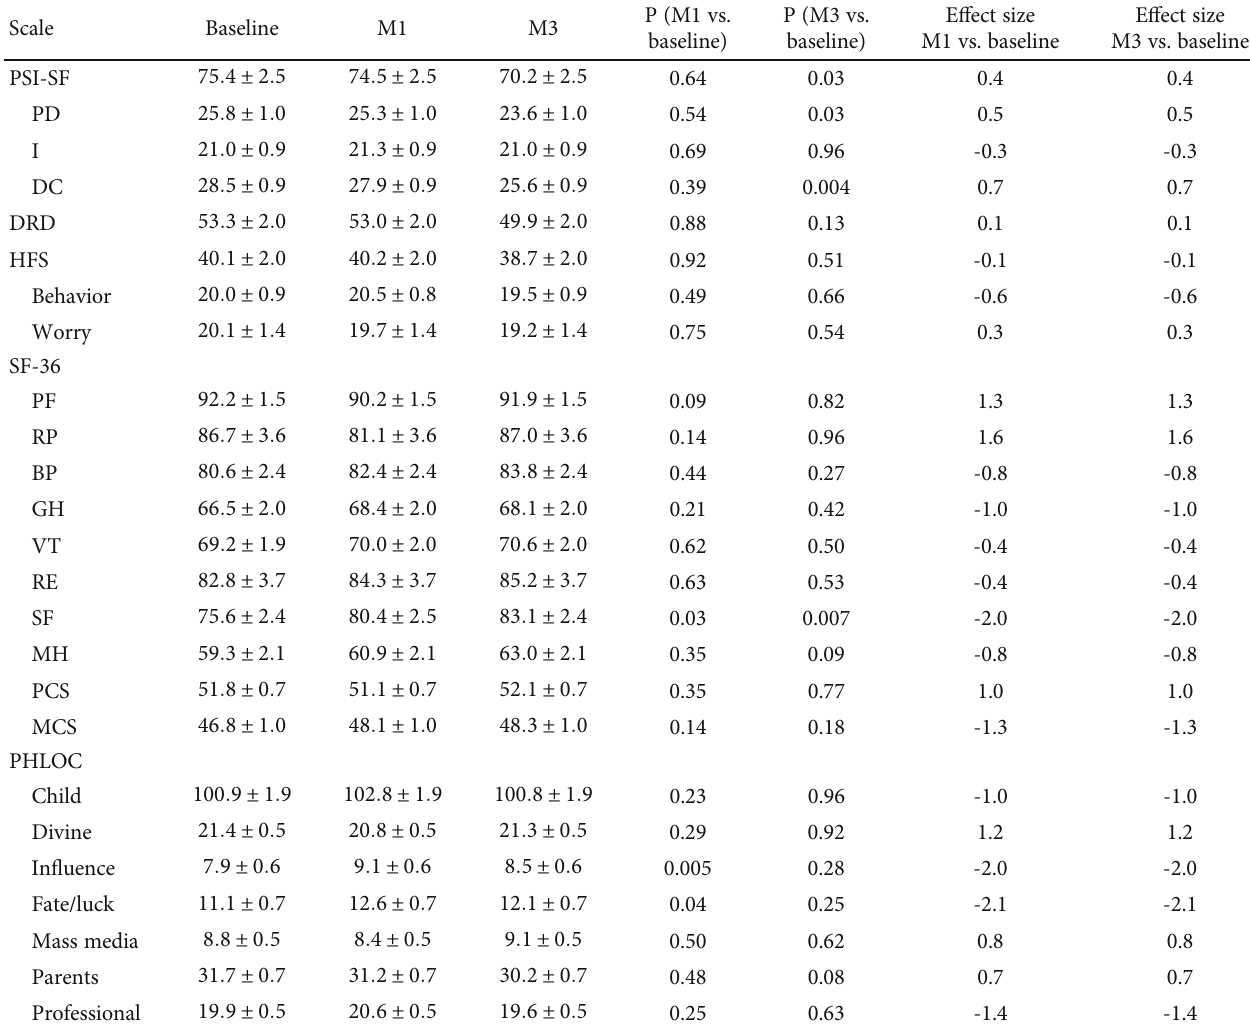
Table 2: Estimated mean scores in the whole